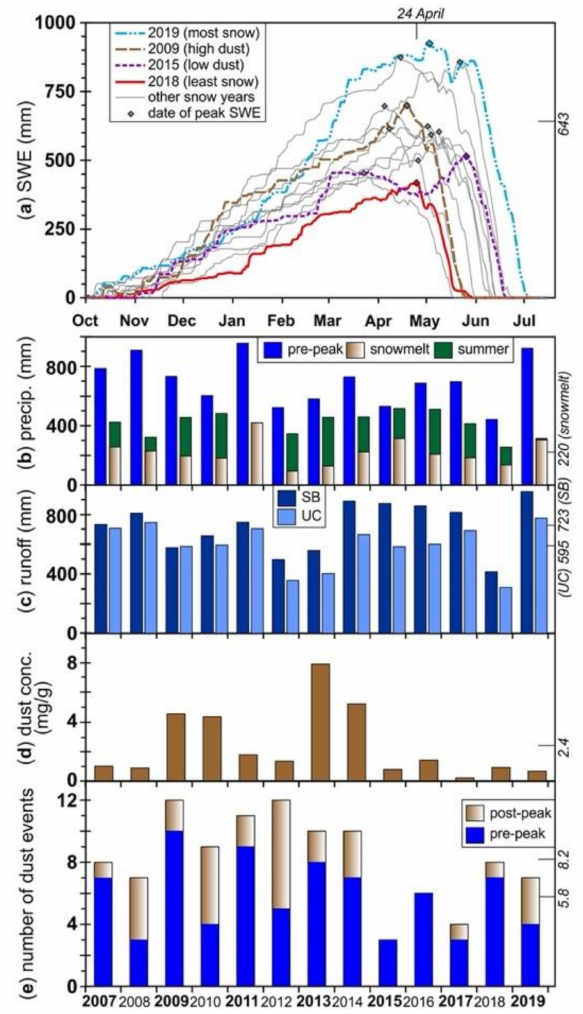
Figure 3. Snow and related data from WY2007 to WY2019 illustrating ( a ) daily SWE from Red Mountain Pass SNOTEL highlighting WY2019 as the maximum peak SWE, WY2009 as a high dust year, WY2015 as a low dust year, and WY2018 as the minimum peak SWE for the period of record (other years are in grey), ( b ) annual total precipitation at SASP divided as pre-peak SWE, and post- peak SWE divided into during and after (summer) snowmelt, ( c ) the annual runoff volume at SBB and the Uncompahgre River (UC), ( d ) the year-end dust concentrations, and ( e ) the number of dust events recorded at SASP observed pre- and post-peak SWE. The mean for each time series is noted on the top or right vertical